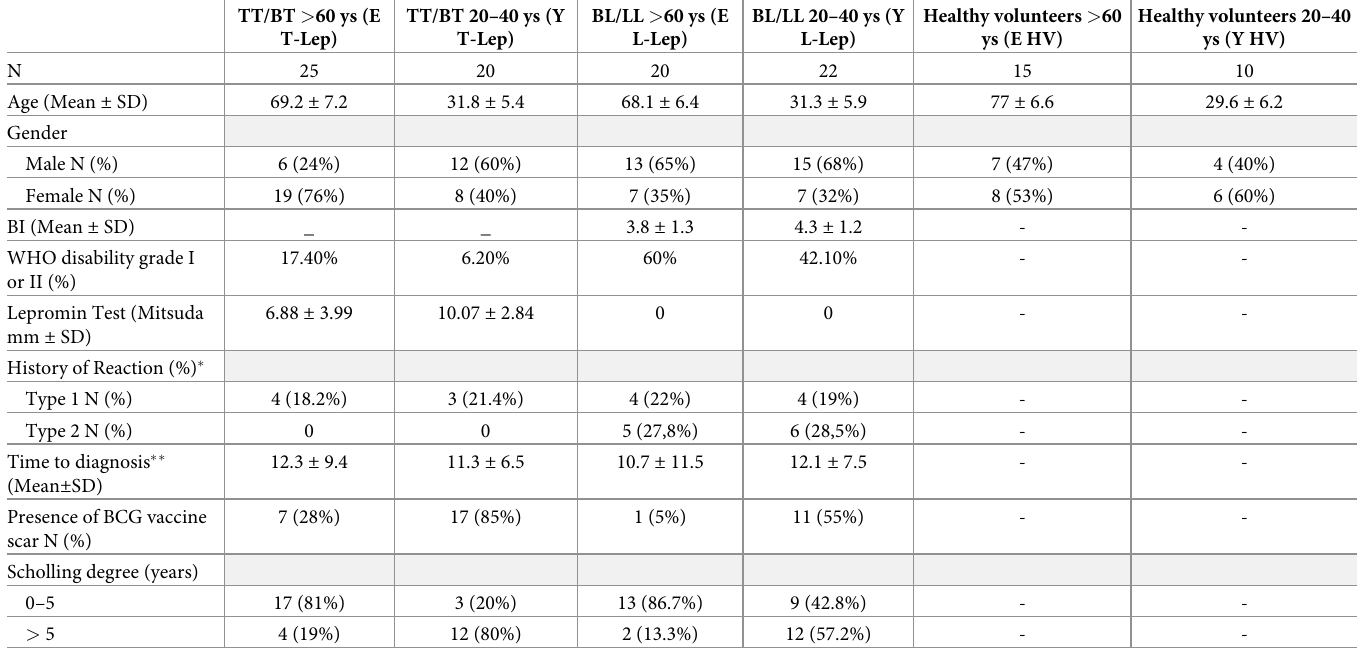
Table 1. Demographic and clinical data of the individuals of this